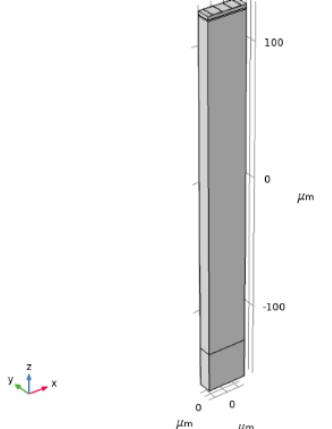
Figure 5. The three-dimensional (3D) primitive cell.